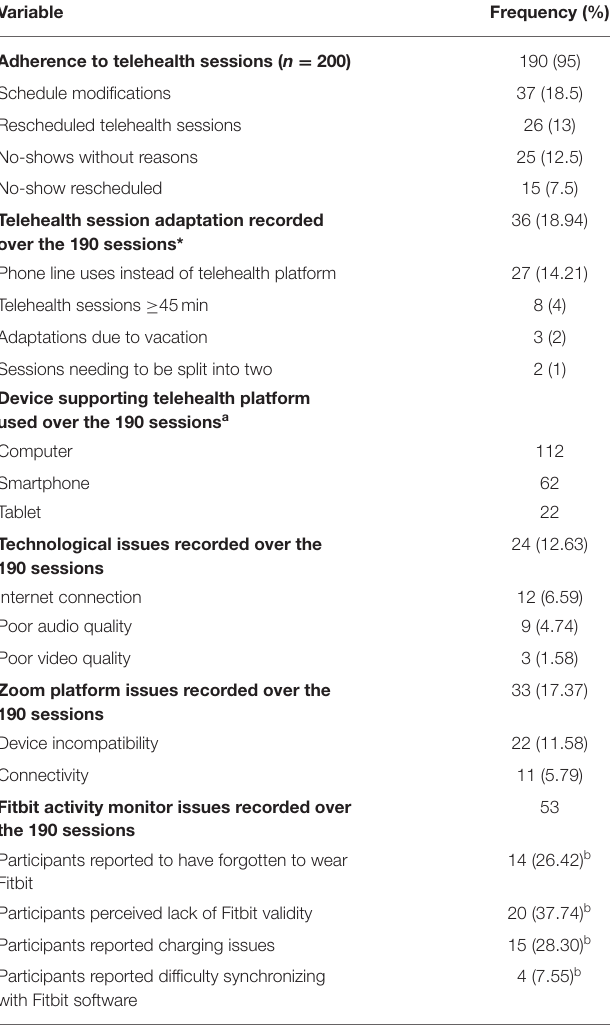
TABLE 2 | Feasibility measures of the telehealth progressive walking intervention ( n =